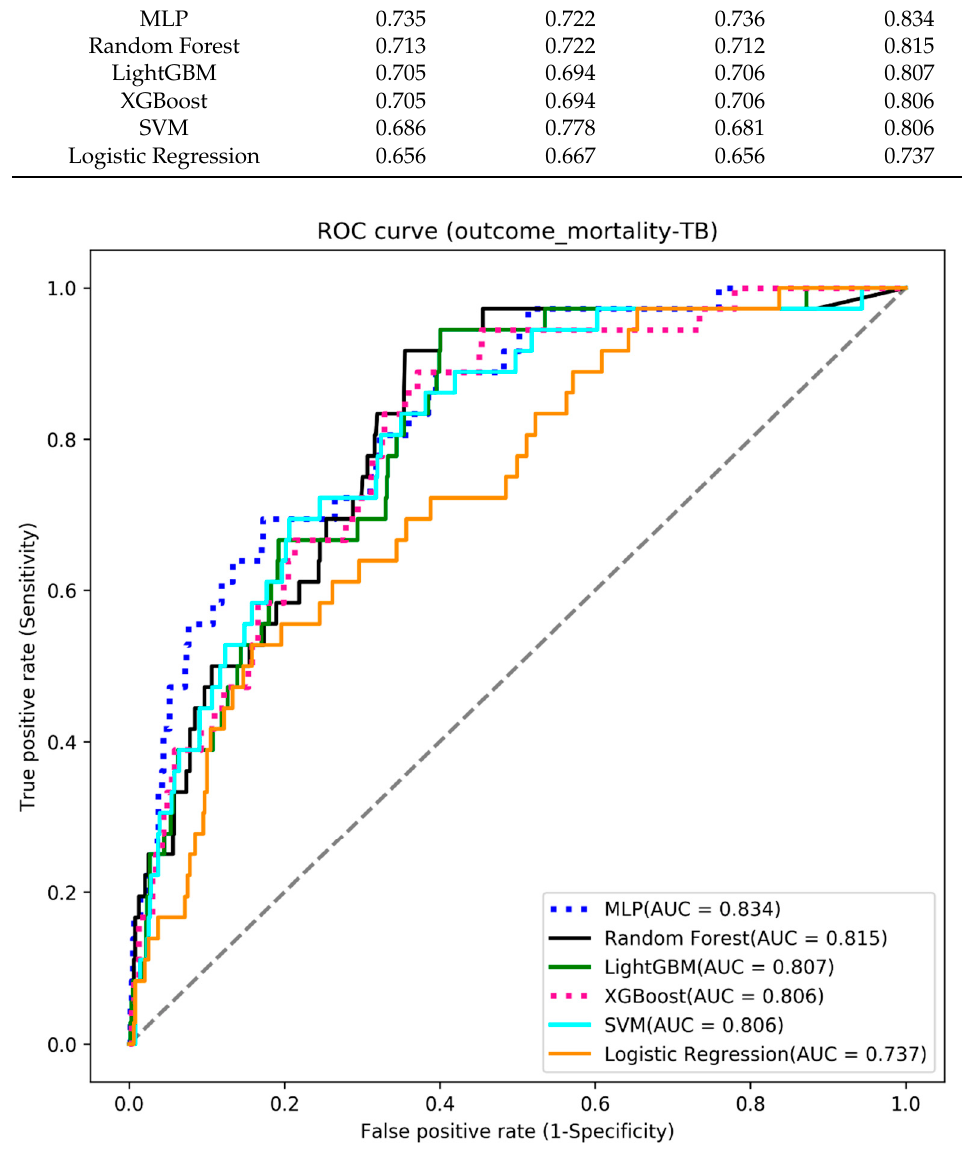
Figure 3. The ROC curve of the mortality models. Table 3. Model results: acute respiratory failure.